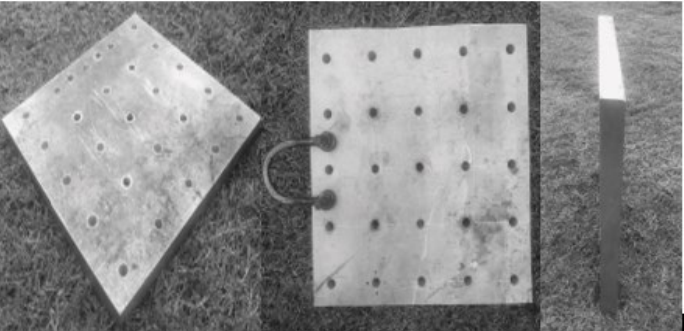
Figure 4. A 25 mm-thick aluminum